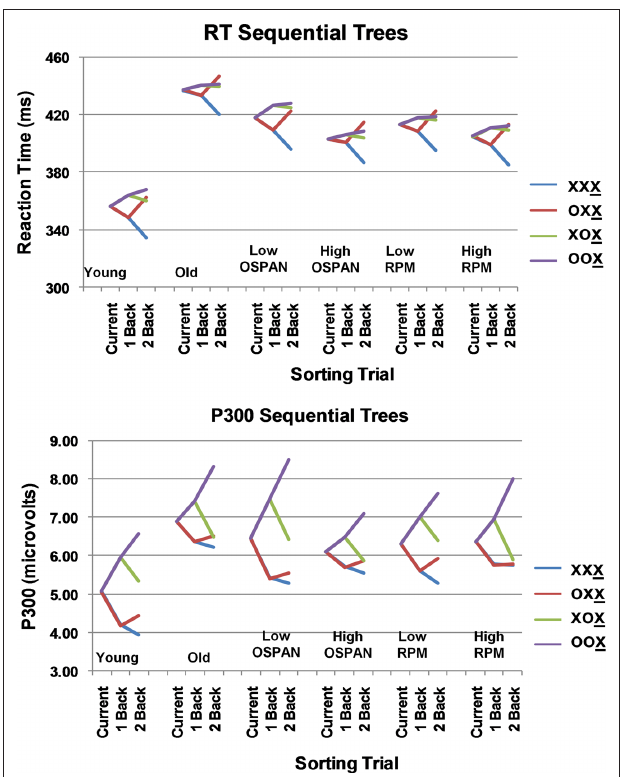
WCST, total number of